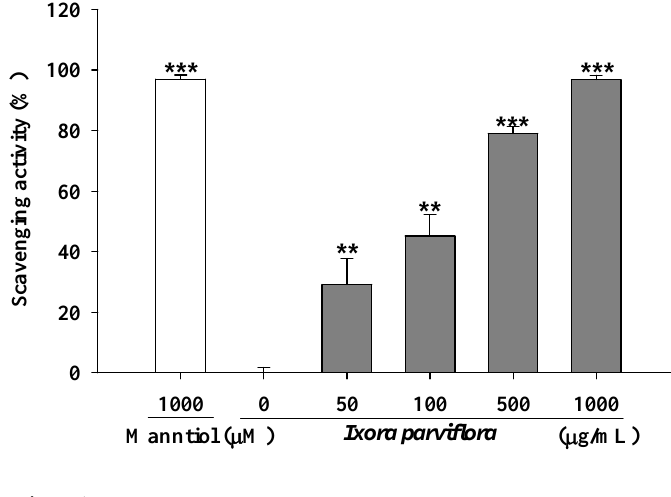
Figure 5. Scavenging hydroxyl radical by IPE. (n = 4; significant difference versus control (without extract): ** , P < 0.01; *** , P <